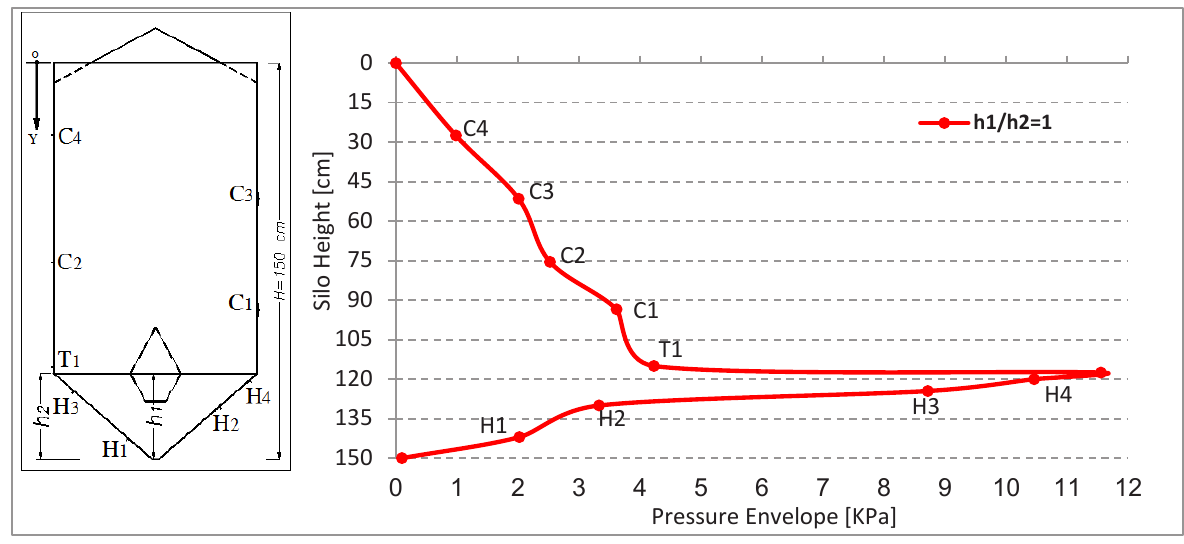
Fig. 8 The pressure distribution on the silo wall and hopper with Insert at position h